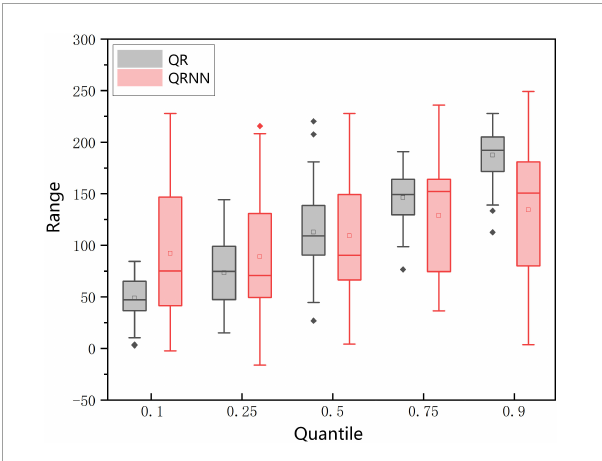
FIGURE4 Boxplot of QR and QRNN fitting values on five quantiles (QR: quantiles regression; QRNN: quantiles regression neural network).